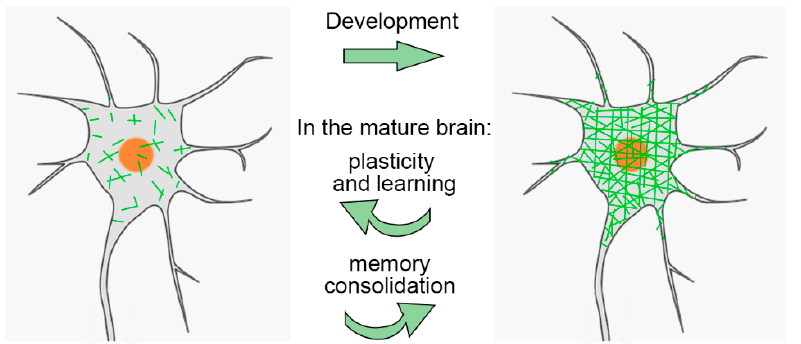
Figure 3. Dynamics of PNNs. The scheme shows that PNN components accumulate and gather around the cell body, proximal dendrites and axon initial segment of a neuron during